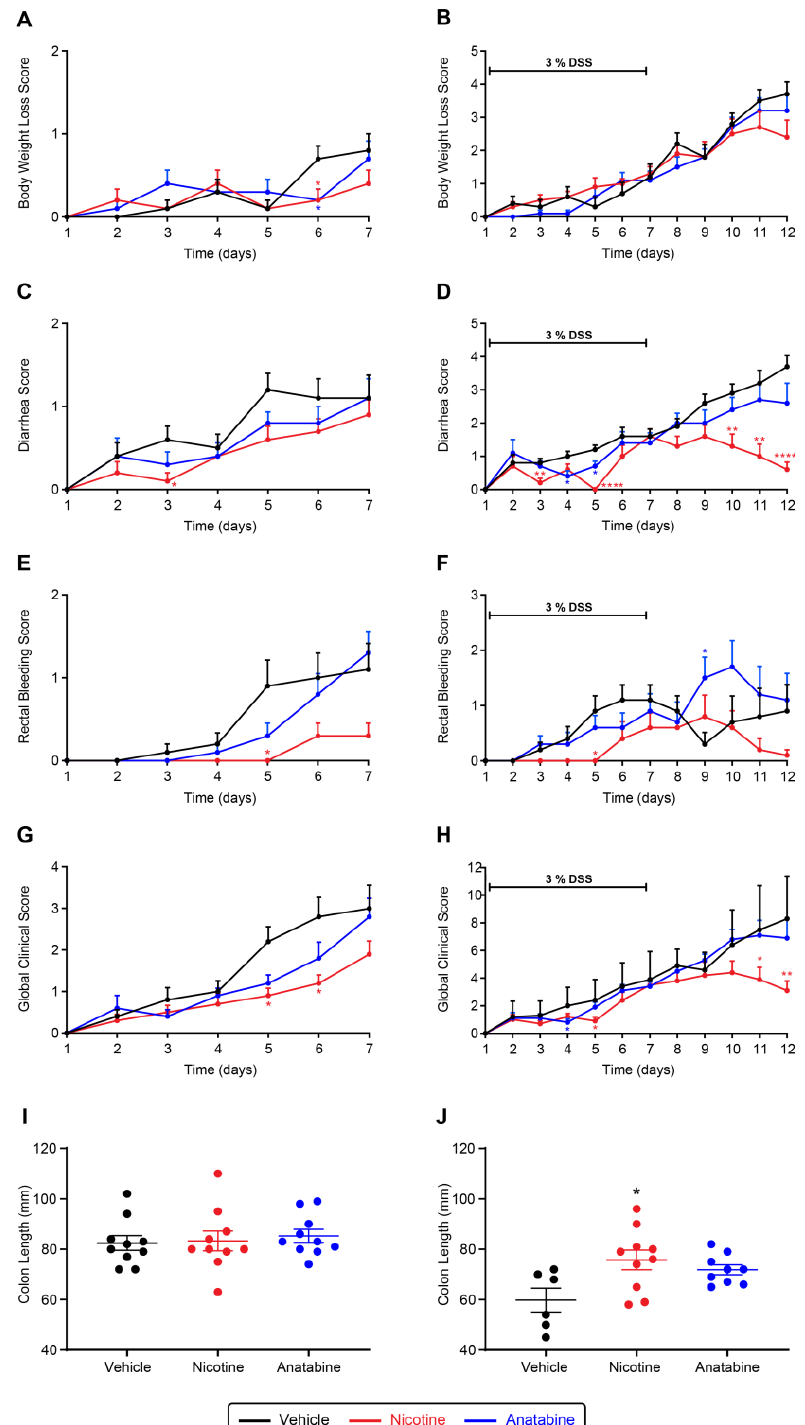
Figure 2. Effect of tobacco alkaloids on clinical parameters of DSS-induced colitis. ( A , C , E , G , I ) acute phase; ( B , D , F , H , J ) recovery phase. Body weight loss ( A , B ), diarrhea ( C , D ), rectal bleeding ( E , F ), and global clinical score; ( G , H ) evolution of DSS-induced hu-mice. Individual colon lengths (mm) with average and SEM measured after sacrifice ( I , J ). Results are expressed as mean ± SEM. * p ≤ 0.05, ** p ≤ 0.01, **** p ≤ 0.0001 compared to vehicle (* red: nicotine vs. vehicle, * blue: anatabine vs. vehicle). Acute phase ( A , C , E , G , I ): n = 10 for all groups. Recovery phase ( B , D , F , H , J ) n = 6 or 9 for vehicle and anatabine, respectively; n = 10 for nicotine.